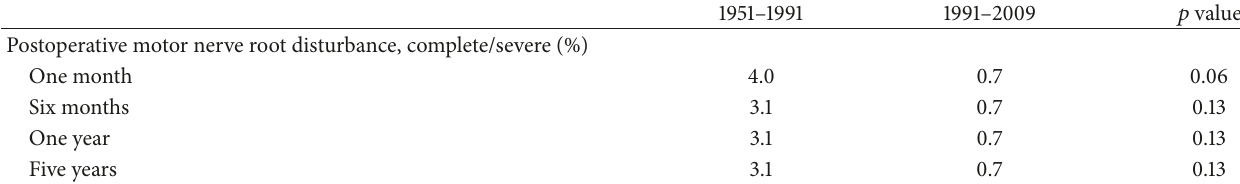
Table 3: Postoperative complete/severe motor nerve root disturbance: comparison between group A and group B.